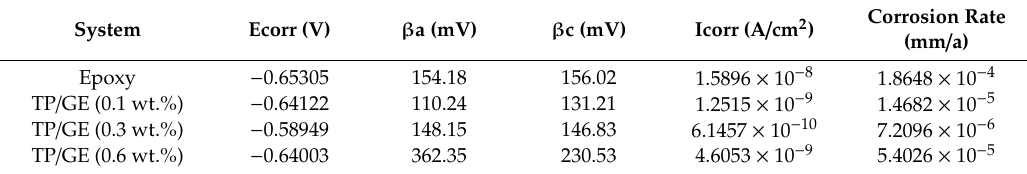
Figure 9. Polarization plots of pure epoxy and nanocomposite TPG. Table 1. Corrosion parameters of the polarization curve of the composite coating.